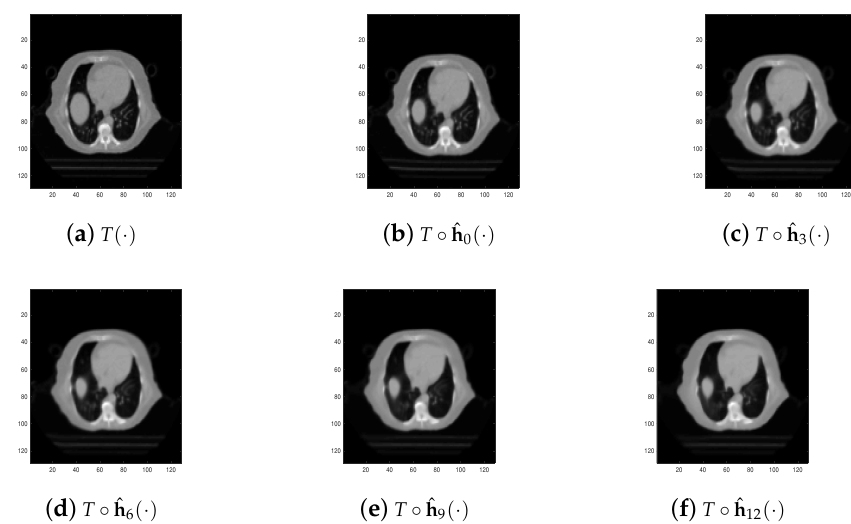
Figure 6. Registration result for different scales on image pairs Lung. ( a ) T ( · ) . ( b ) Re − SSD = 6%. ( c ) Re − SSD = 3.08%. ( d ) Re − SSD = 2.98%. ( e ) Re − SSD = 2.91%. ( f ) Re − SSD = 2.88%.